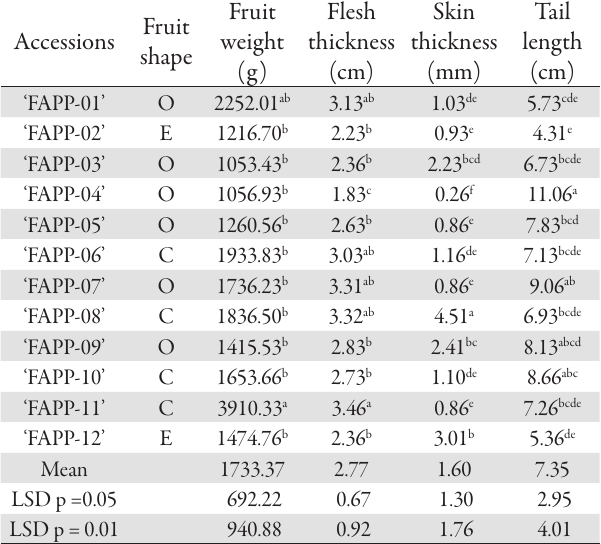
Tab. 2. Variability of some morphological-biometrical parameters for pumpkin populations